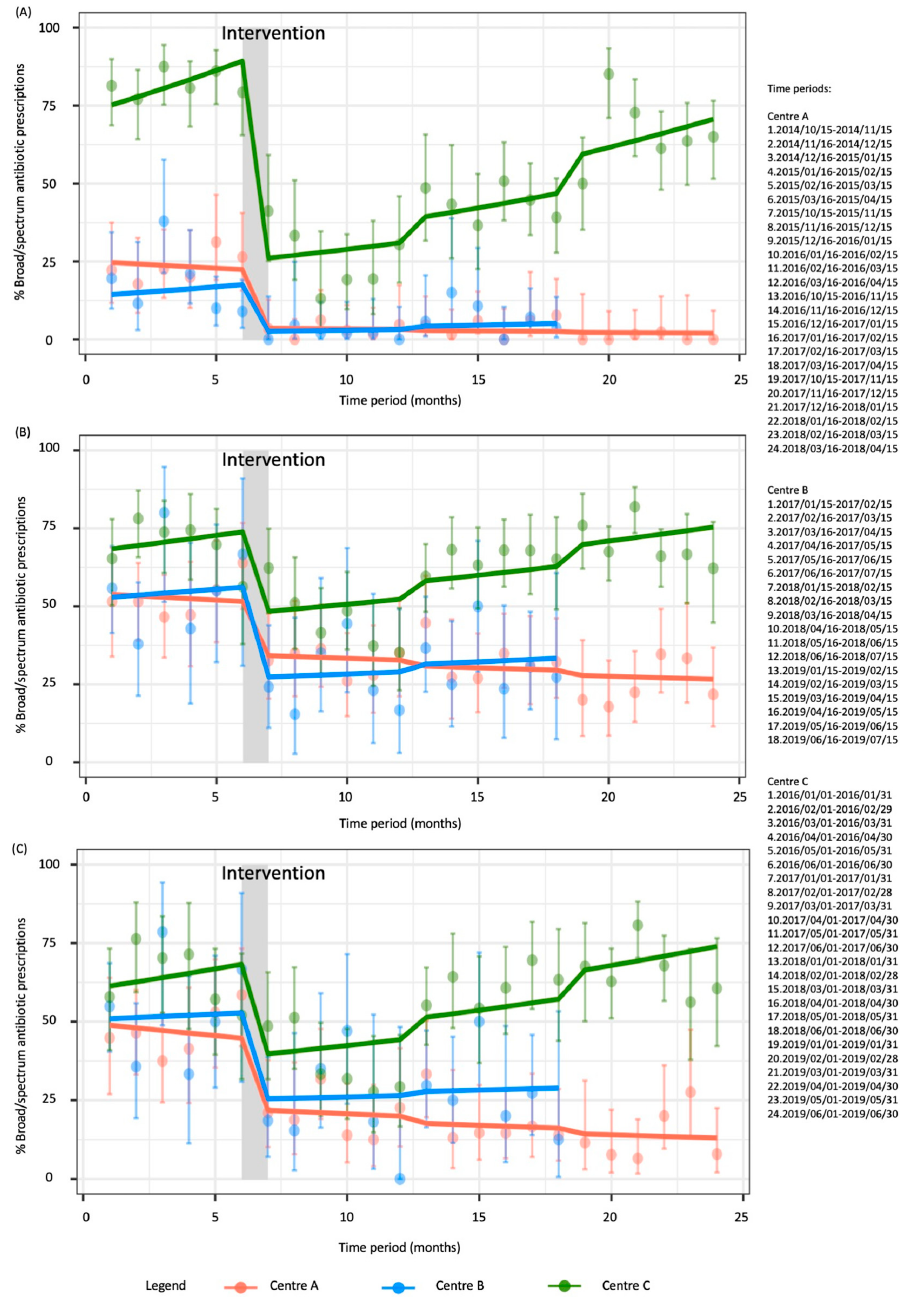
Figure 1. Interrupted time series of monthly broad-spectrum antibiotics prescriptions (dots) expressed as percentages with 95% confidence intervals (bars) for ( A ) pharyngitis, ( B ) acute otitis media, and ( C ) non-complicated acute otitis media in the three centers. The lines represent the broad-spectrum prescriptions trend in the different centers.